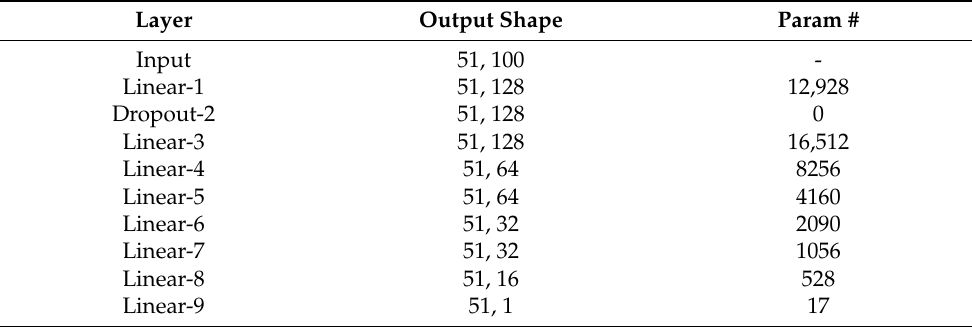
Table 3. DNN structures generated using data selected by feature selection. Layer Output Shape Param # Input 51, 100 - Linear-1 51, 128 12,928 Dropout-2 51,